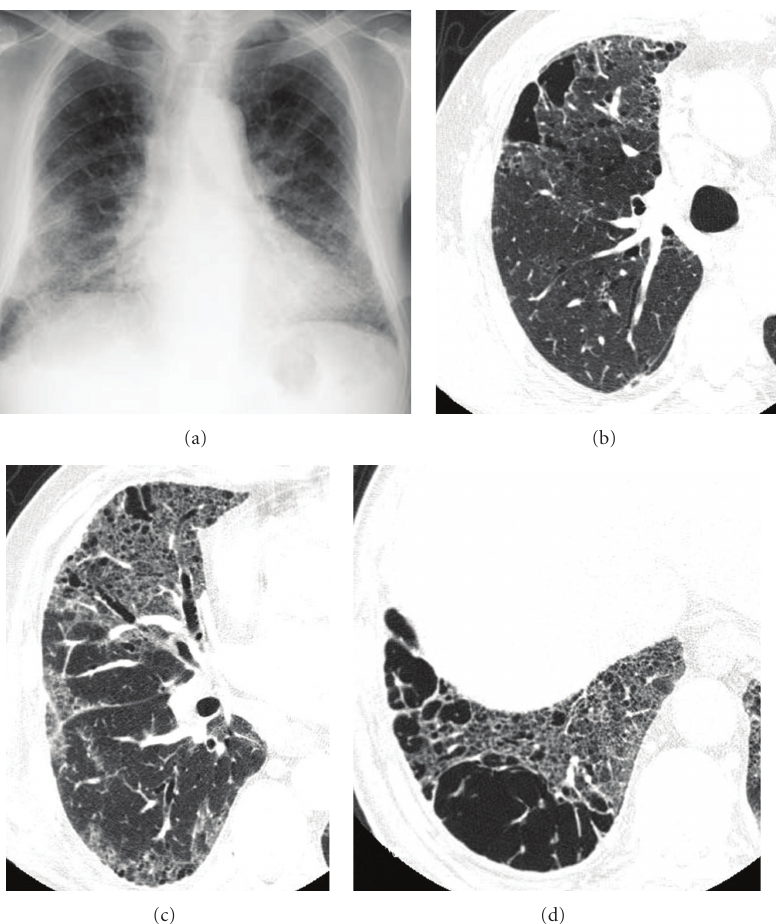
Figure 1: Di ff use interstitial pneumonia (nonspecific interstitial pneumonia (NSIP) pattern) with emphysema. (a) Chest X-ray shows bibasilar ground glass and reticular opacity. Volumes of bilateral lungs are almost normal. (b) High-resolution computed tomography (HRCT) of upper lung shows centrilobular pulmonary emphysema. (c), (d) HRCT of lower lung shows ground glass opacity along the bronchovascular bundle including cysts with varying size. Distribution of abnormal opacity mimics